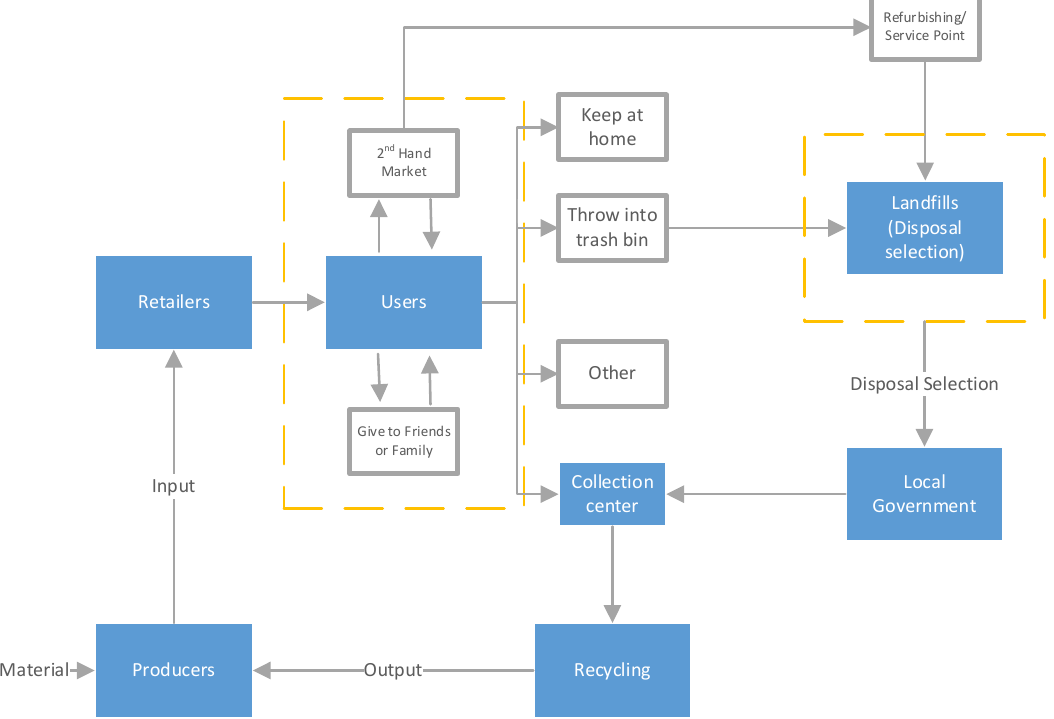
Fig. 6: Used cellphone flow in Jabodetabek